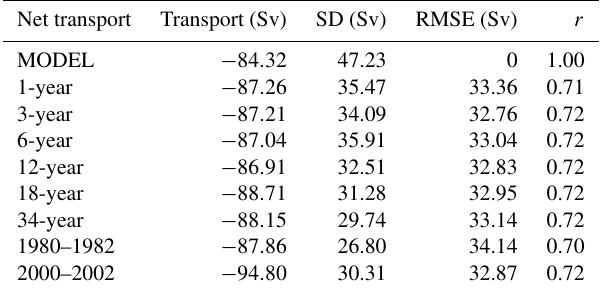
Table 3. Transport statistics and correlation results obtained from calculating the box transport proxy over a range of time